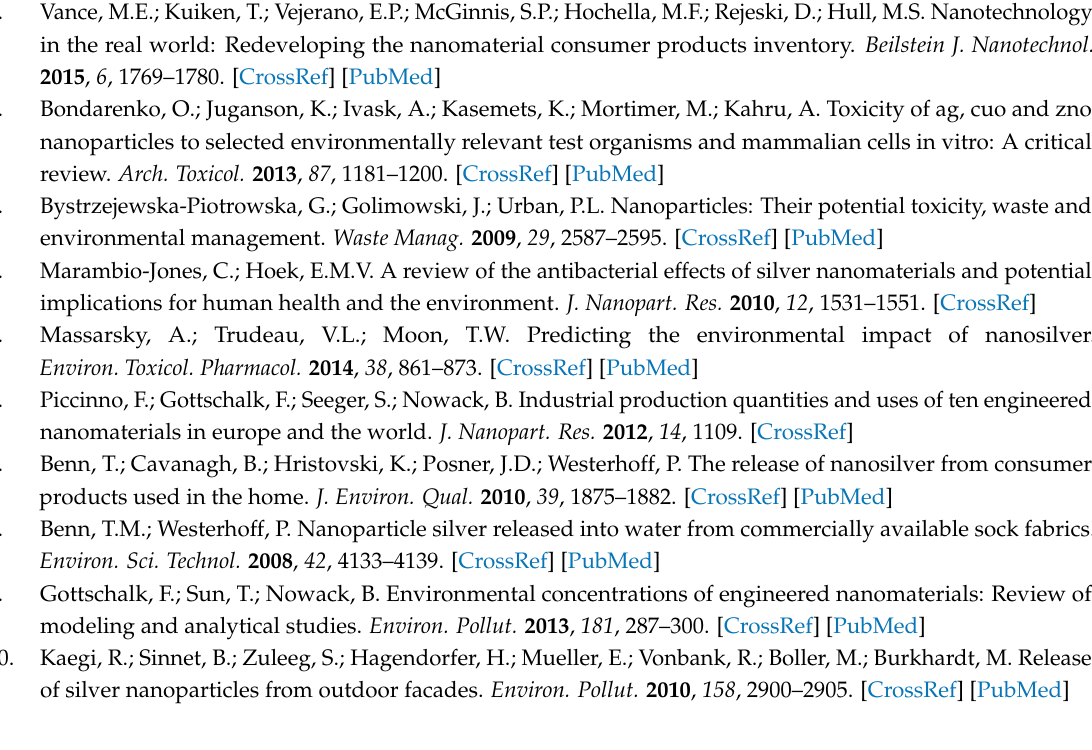
Figure S1: Representative images of zebrafish with and without significant developmental impacts, Figure S2: Average zeta potential and hydrodynamic diameter (HDD) of particle formulations over a five day period in fishwater. Figure S1a,b are average zeta potential measurements for the formulation components (a) and the dialyzed formulations (b), and Figure S1c,d are the average HDD measurements for the formulation components (c) and the dialyzed formulations (d), Figure S3: Concentration-response comparisons for formulation components (a) and dialyzed materials (b) based on zebrafish mortality at 120 hpf (a) Significant differences ( p ≤ 0.05) existed between materials in the formulation component treatments. The lignin particle exhibited the lowest toxicity, followed by silver, and PDAC. (b) No significant differences ( p > 0.05) existed in the dialyzed sample treatments. Comparisons included the two full formulations (NP + Ag + PDAC) and the three NP + Ag formulations, Figure S4: Concentration–response curve for silver nitrate based on zebrafish mortality at 120 hpf, Figure S5: Frequency of delayed hatching in zebrafish embryos exposed to Ag + as silver nitrate in fishwater. Asterisk represents significant increase ( p ≤ 0.05) relative to unexposed (control) fish embryos, Figure S6: Frequency of delayed developmental progression in zebrafish embryos exposed to lignin nanoparticles in fishwater. Asterisk represents significant increase ( p ≤ 0.05) relative to unexposed (control), Table S1: Metadata associated with zeta potential